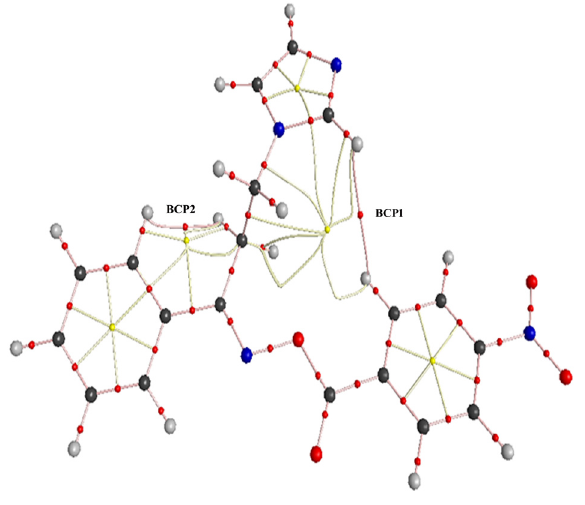
Figure 7: The topological diagram of the IPAONM molecule.